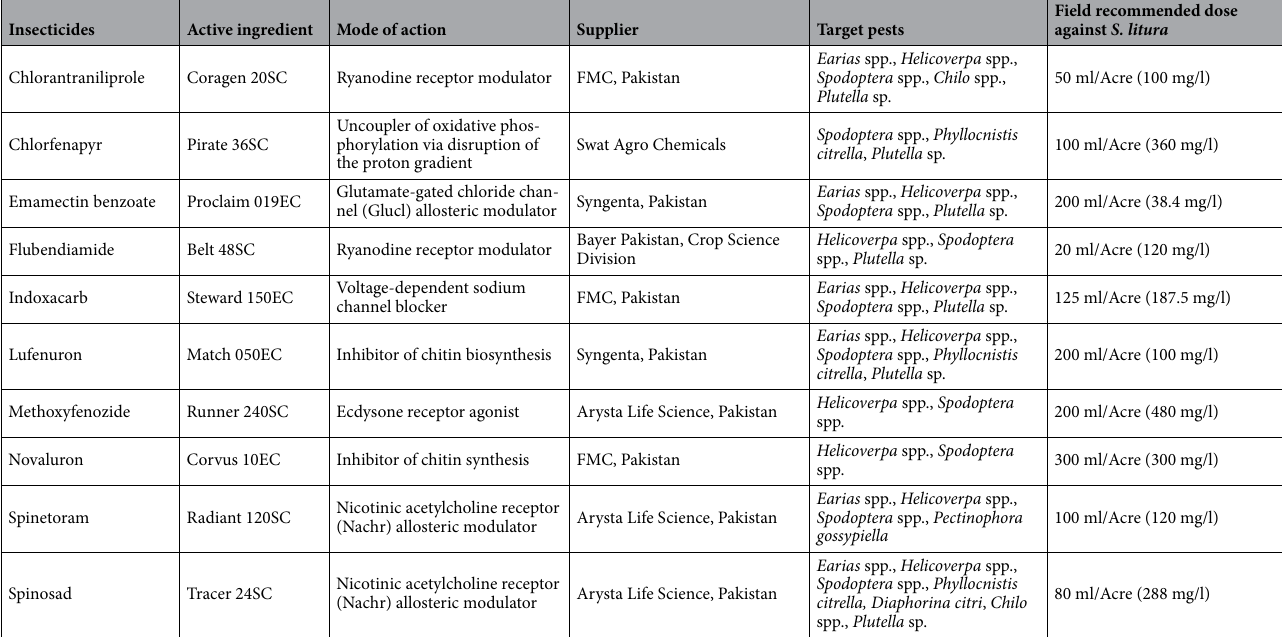
Table 1. List of insecticides selected for use against S. litura in Pakistan.